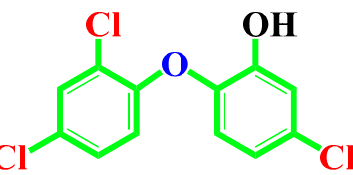
Figure 1. Chemical structure of Triclosan (TCS).